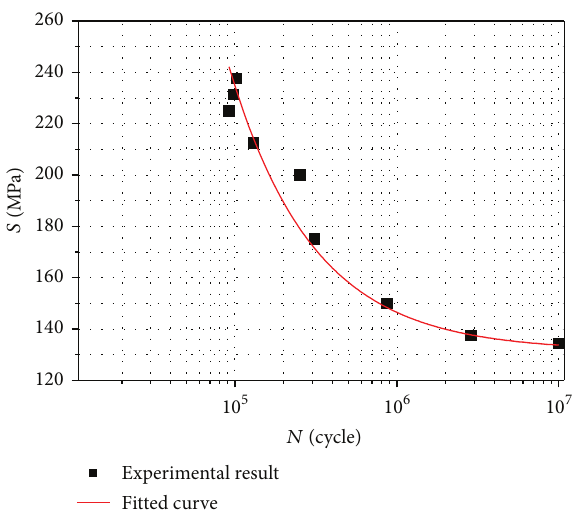
Figure 3: Experimental fatigue lives and fitted S-N relationship.